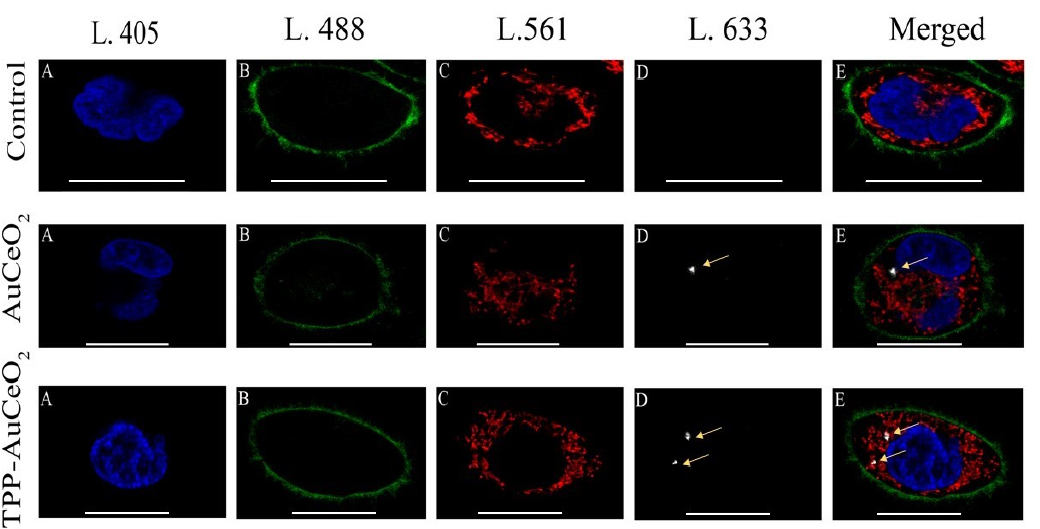
Figure 4. In vivo confocal microscopy images of cellular uptake of AuCeO 2 and TPP–AuCeO 2 (20 µg/mL) in HeLa cells after 24h incubation.( A ) Blue (Hoechst) to label the nucleus; ( B ) Green (CellMask TM ) to label the cell membrane; ( C ) Red (MitoTracker TM ) to label the mitochondrial; ( D ) light reflection of NPs at 633 nm (white spots, indicating the location by yellow arrow); and ( E ) colocalization of the cells and the NPs, showing the internalization of these NPs in both treatments (merged). (Scale bar = 20 µm).